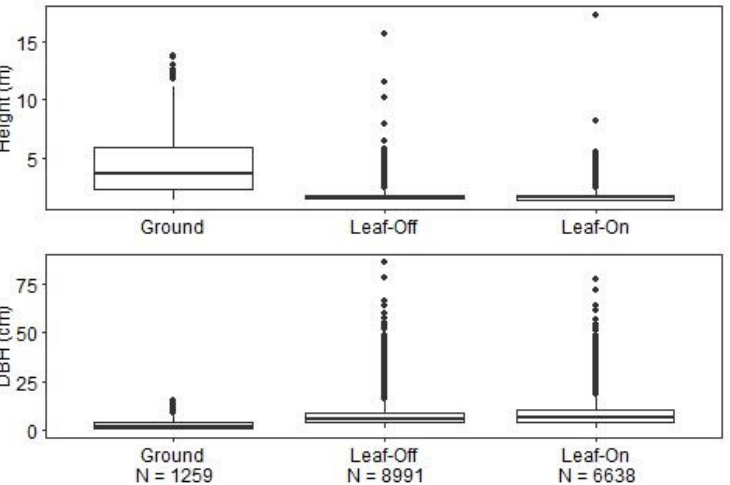
Figure 4. Boxplots showing the distribution of tree height and DBH values from the three measure- ment periods (ground validated, leaf-off LiDAR, leaf-on LiDAR). The total number of trees included for each period is shown along the x -axis.